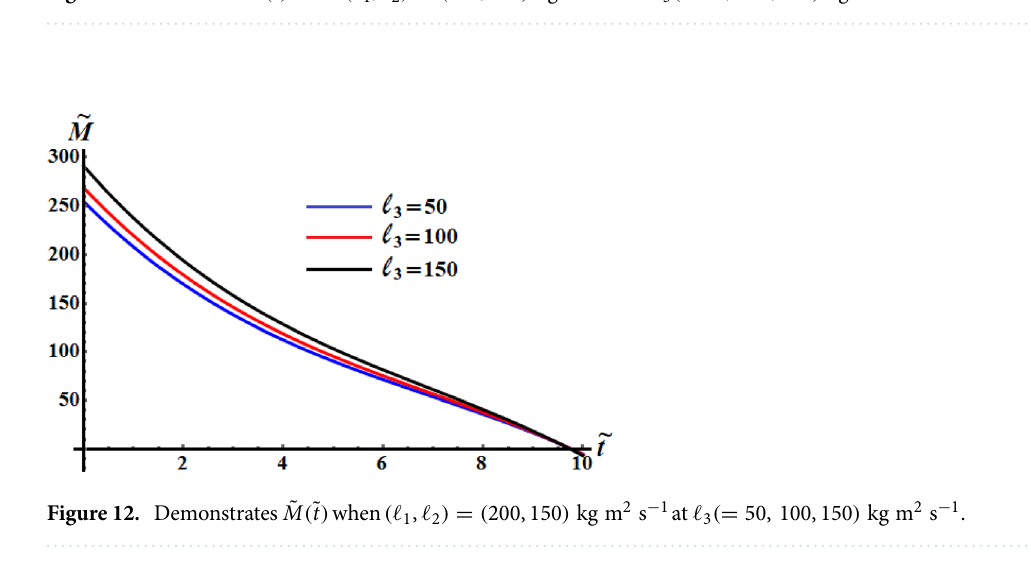
Figure 11. Illustrates ˜ H ( ˜ t ) when (ℓ 1 , ℓ 2 ) = ( 200, 150 ) kg m 2 s − 1 at ℓ 3 ( = 50, 100, 150 ) kg m 2 s − 1